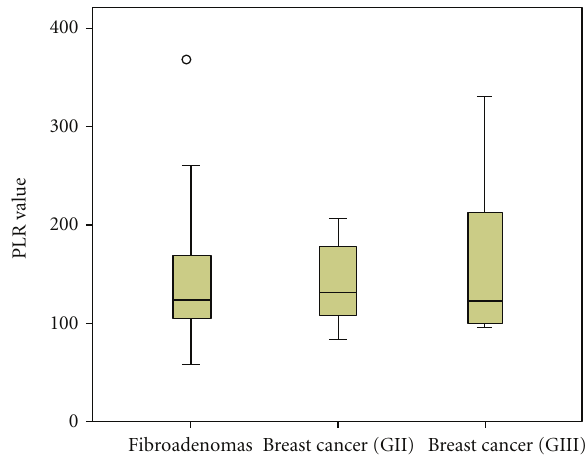
Figure 1: PLR values within groups A, B, and C (fibroadenomas, invasive ductal carcinoma grade II and III, resp.).